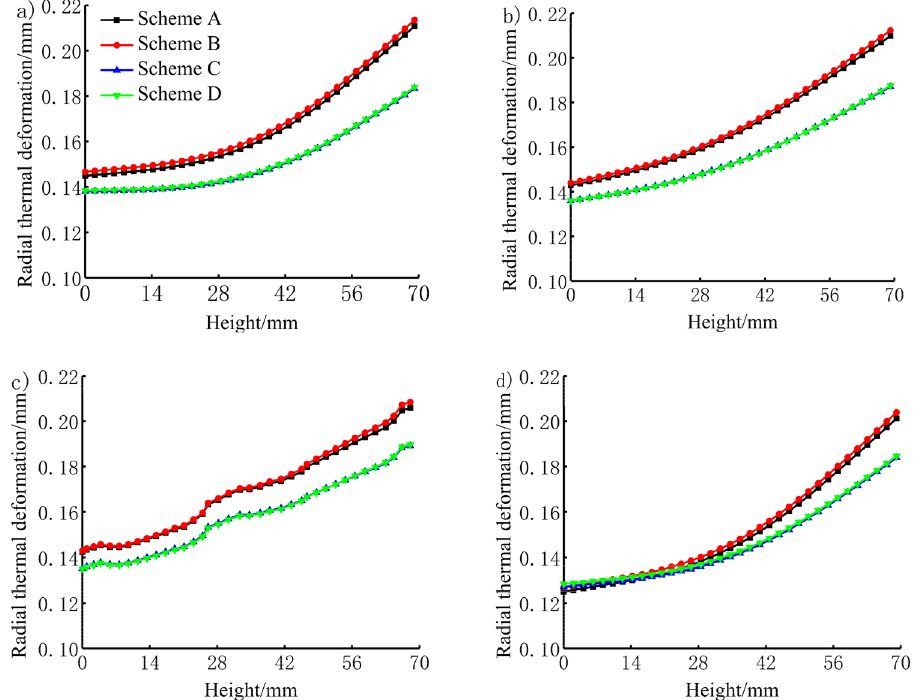
Figure 12. Radial thermal deformation in the axial direction of ( a ) 0° of the piston skirt, ( b ) 30° of the piston skirt, ( c ) 60° of the piston skirt and ( d ) 180° of the piston